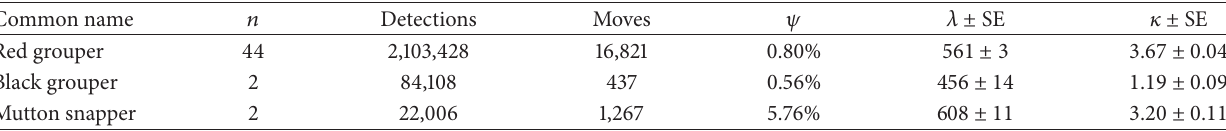
Note: n denotes number of fish with detected movement used to parameterize model, 𝜓 denotes probability of movement during 5min interval, 𝜆 denotes mean of exponential distribution of movement distances, and 𝜅 denotes mean of von Mises distribution of turning angles between movements, relative to home range